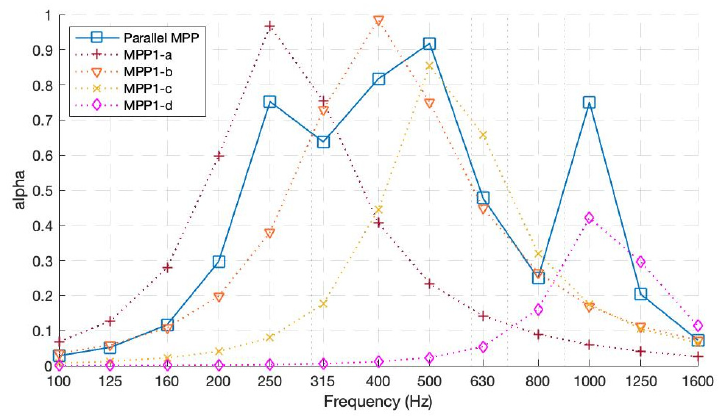
Figure 9. Theoretical absorption coefficients for Prototype 1 and each of its constituting MPPs.